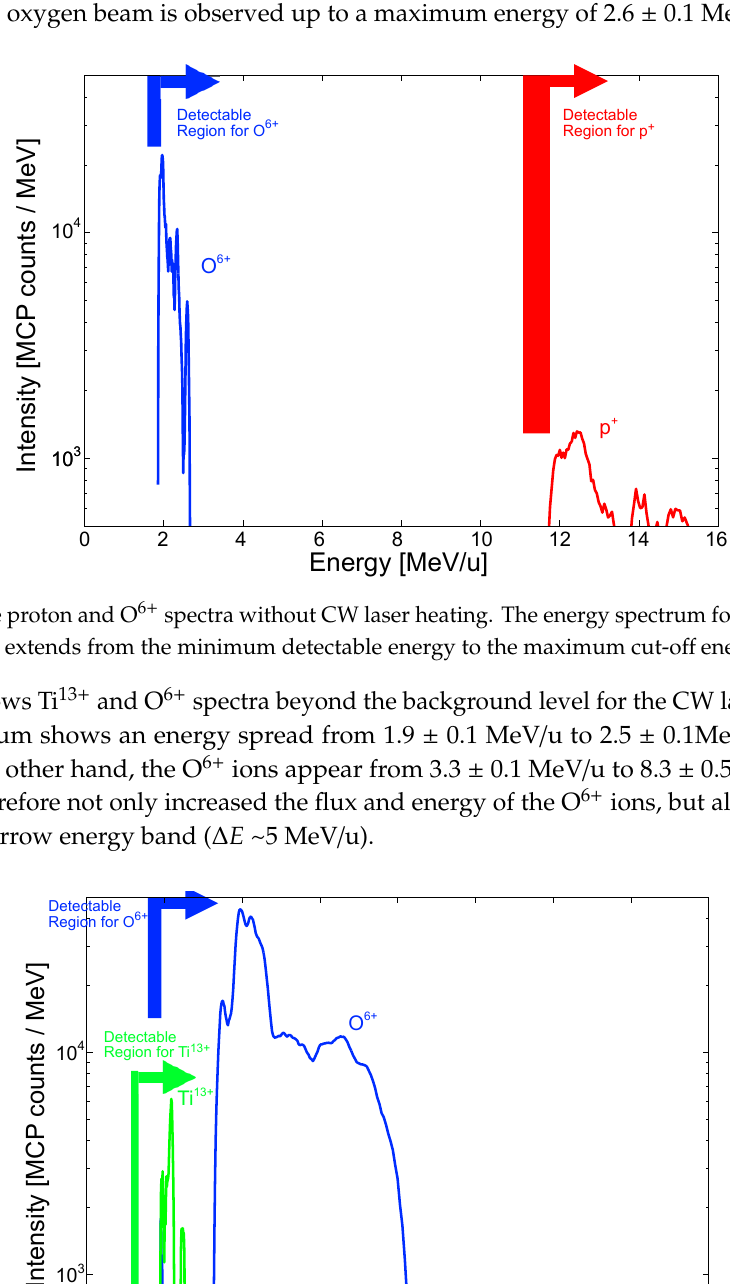
Figure 5. Images of the micro channel plate (MCP) for the Thompson parabola (TP) spectrometer showing parabolic tracks for each ion charge to mass ratios. The brightest points on the bottom right of the images are fixed to the origins of the parabolic curves. The dashed circle shows the MCP size, which determines the minimum detectable energy of ions. (a) shows the ion tracks obtained without CW laser heating, and (b) shows ion tracks obtained with CW laser heating.